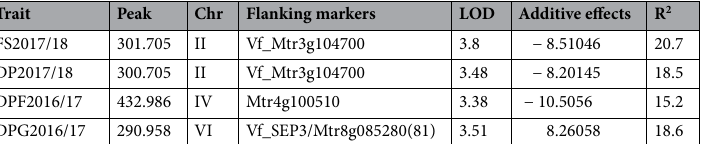
Table 4. Trait name, peak position (cM), chromosome (Chr), flanking markers, LOD scores, additive effects and phenotypic variation explained (R 2 ) by the QTLs for dehiscence resistance detected in the Vf6 x Vf27 RIL